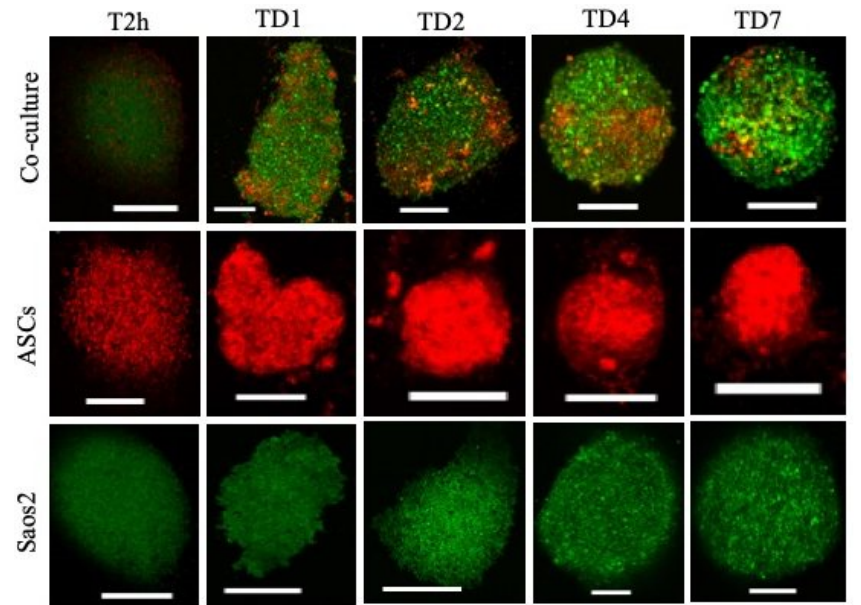
Figure 2. Time-lapse analyses of homo and heterotypic tumorspheres. PKH67 green fluorescent- labeled human Saos 2, PKH26 red fluorescent-labeled ASCs. Scale bar = 250 μ m.